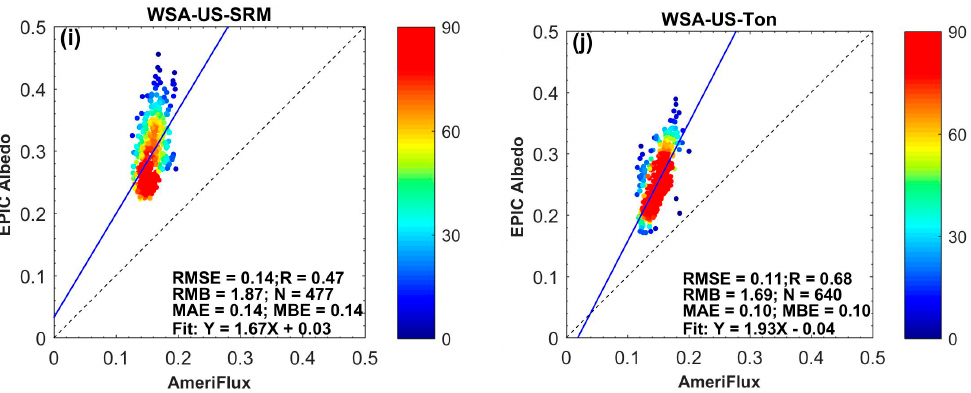
Figure 5. Validation results of hourly EPIC albedo over di ff erent land cover types in 2016. The land cover type of ( a , b ) is croplands, ( c , d ) is evergreen needleleaf forests, ( e , f ) is grasslands, ( g , h ) is permanent wetlands, and ( i , j ) is woody savannas. The color bars and numbers on the right indicate the density of the matching data. RMSE, root mean square error; RMB, relative mean bias; MAE, mean absolute error; MBE, mean bias error. Table 2. Statistics comparing the AmeriFlux ground-based measurements with the EPIC albedo. Land Cover